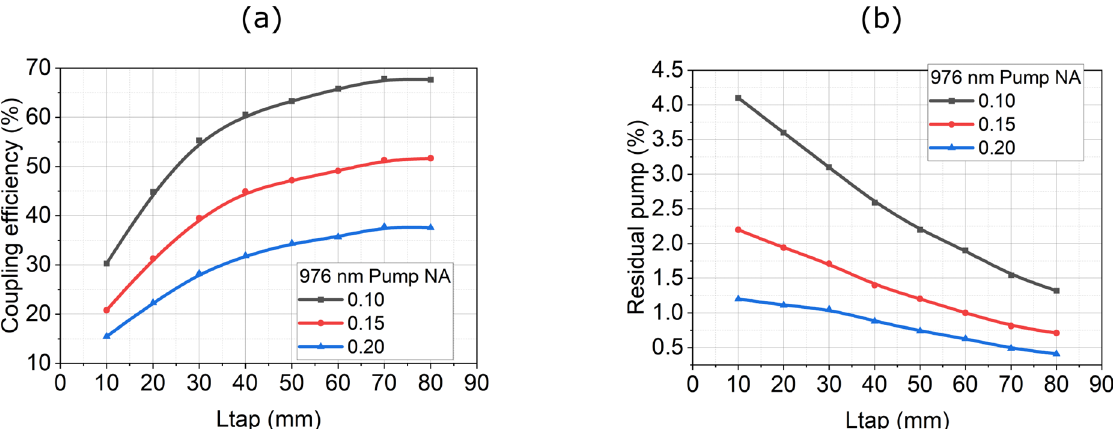
Figure 2. ( a ) Simulated pump coupling efficiency of the proposed pump combiner design for three pump radiation NAs at 976 nm. ( b ) Simulated residual pump fraction of the combiner for three pump radiation NAs at 976